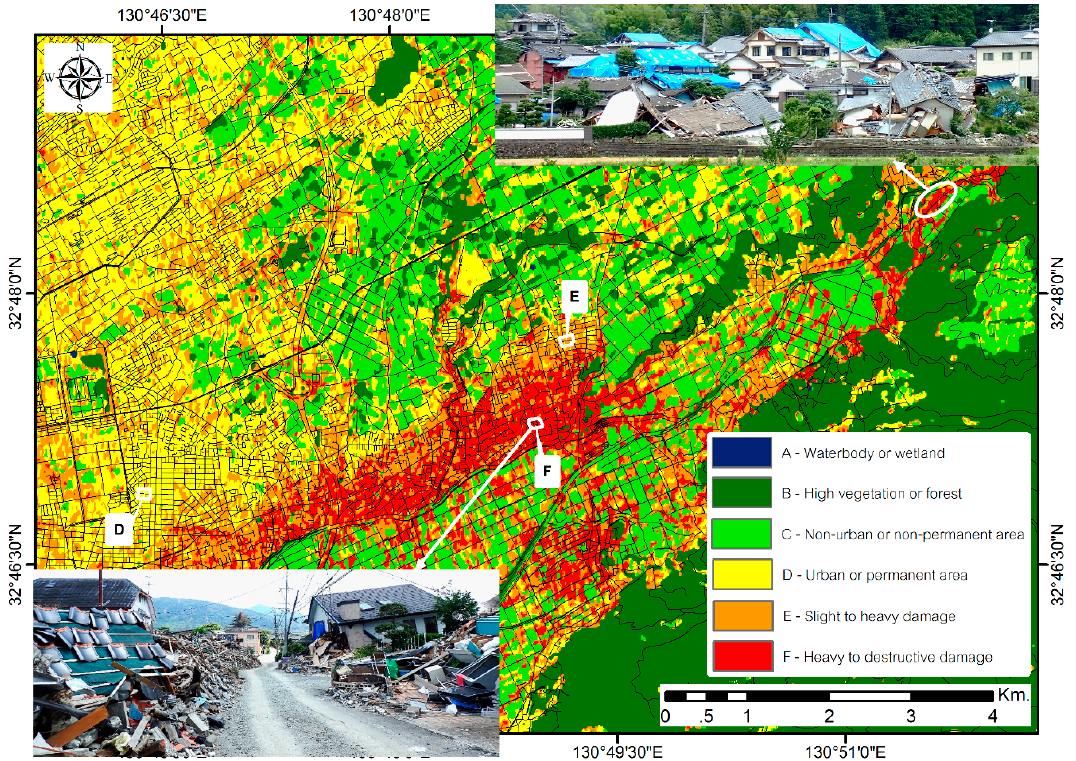
Figure 7. Damage assessment map for the area around Mashiki town. D, E, and F are locations of ground truth examples in Figure 6.